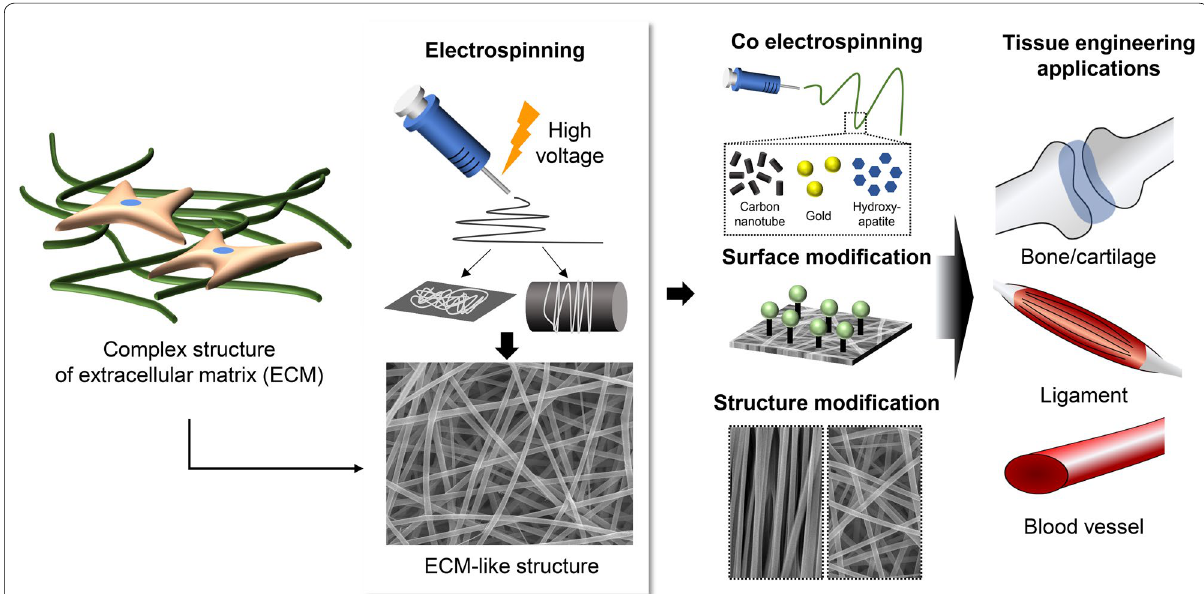
Fig. 1 Application of electrospun nanofibers mimicking extracellular matrix (ECM) in tissue